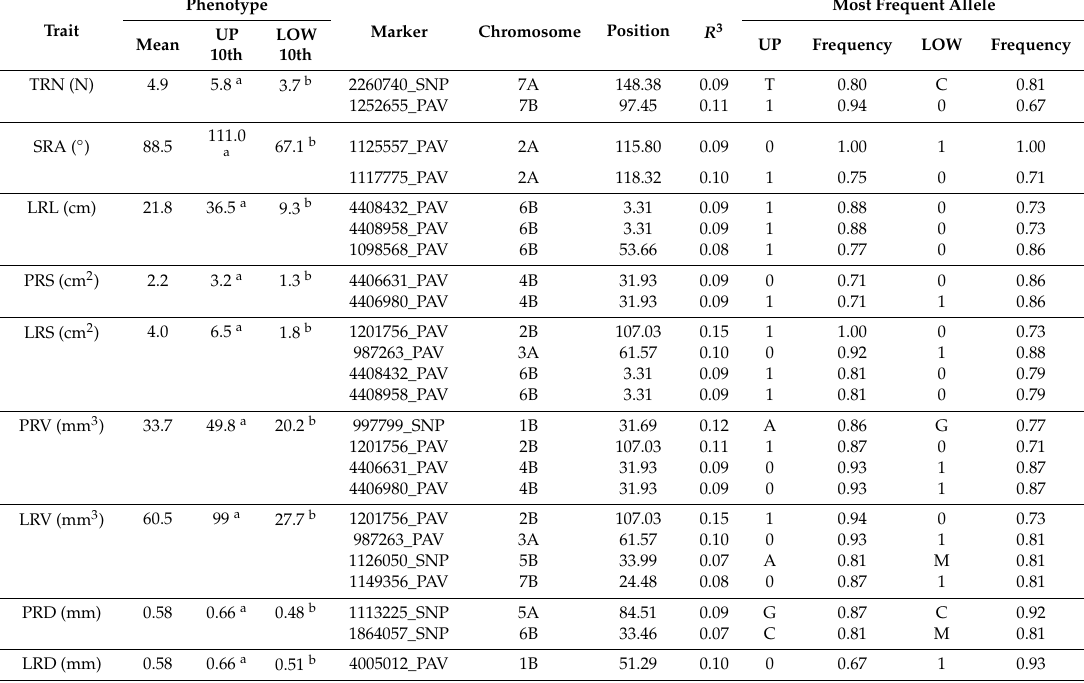
Table 4. Selected significant markers from the GWAS with di ff erent allele composition for the upper (UP) and lower (LOW) 10th percentile of genotypes. Di ff erent letters on the UP and LOW 10th phenotype indicate that means are significantly di ff erent at p < 0.01 following a Tukey test.